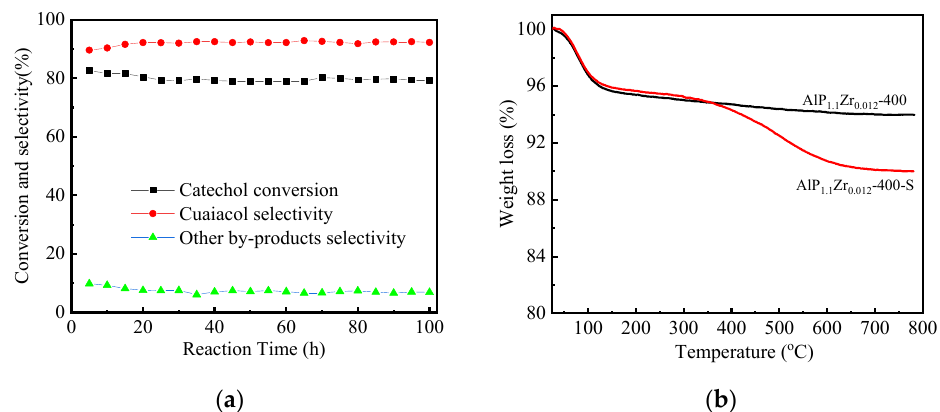
Figure 8. ( a ) Catalytic properties as a function of time for the selective O- methylation of catechol over AlP 1.1 Zr 0.012 -400 catalysts. Reaction condition: m cat = 2 g, Reaction temperature = 280 °C, LHSV = 0.2 h − 1 , methanol/catechol = 5 (mol). ( b ) TG profiles of the AlP 1.1 Zr 0.012 -400 and AlP 1.1 Zr 0.012 -400-S catalysts.